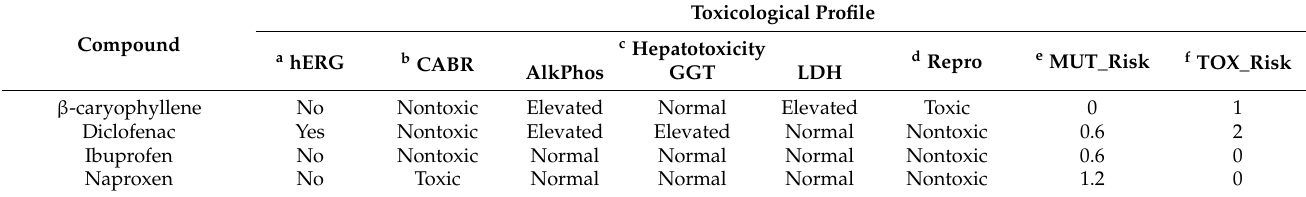
Table 9. Toxicological profile of β -caryophyllene comparing to commercial anti-inflammatories drugs (diclofenac, ibuprofen, and naproxen); a Qualitative estimation of the likelihood of the hERG potassium channel inhibition in human (hERG); b Qualitative estimation of triggering the mutagenic chromosomal aberrations (CABR); c human liver adverse effect as the likelihood of causing an elevation in one of the following enzymes: alkaline phosphatase, GGT, and LDH; d qualitative estimation of reproductive toxicity; e represents the risk of mutagenicity assessed by ten models of “virtual Ames testing.” (MUT_Risk); f represents the overall toxicological risk (TOX_Risk). Toxicological